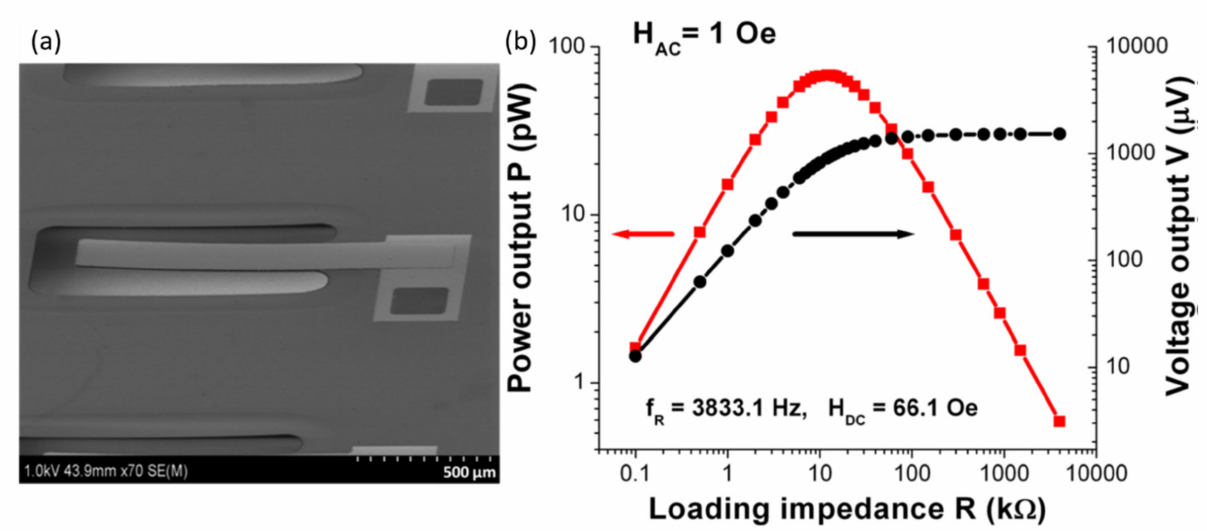
Figure 15. ( a ) SEM image of the all-thin-film ME energy harvester. ( b ) Energy harvesting performance of the ME energy harvester at the resonance frequency of 3833.1 Hz at H dc = 66.1 Oe. The harvested AC magnetic field is 1 Oe. Reprinted with permission from ref. [69]. Copyright 2021 AIP